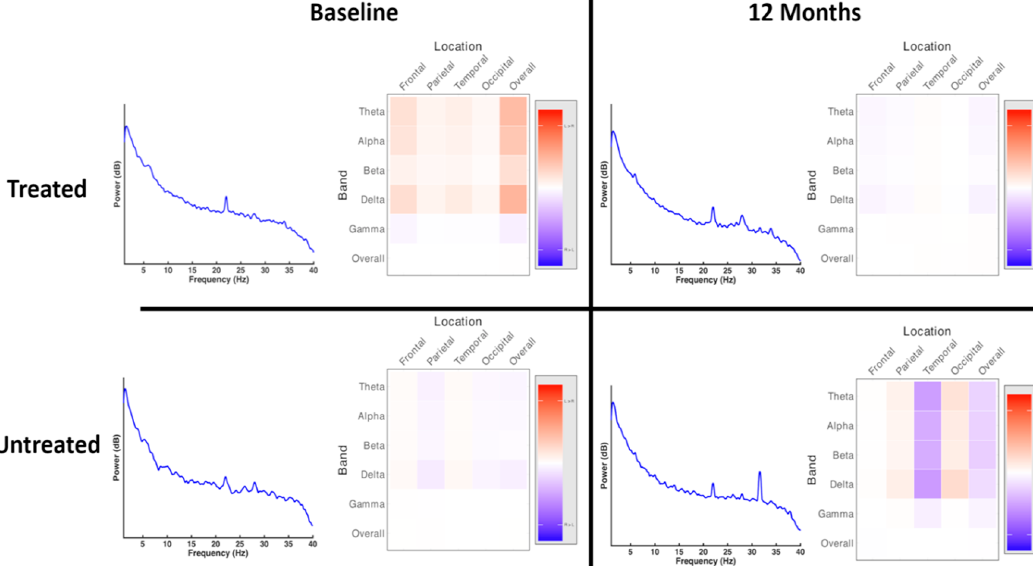
Figure 2. Power spectra and distribution of spectral power at baseline and at 12 months, treated and untreated groups. There were no statistically significant differences in the overall power spectrum or in asymmetry between groups at baseline or at 12 months.